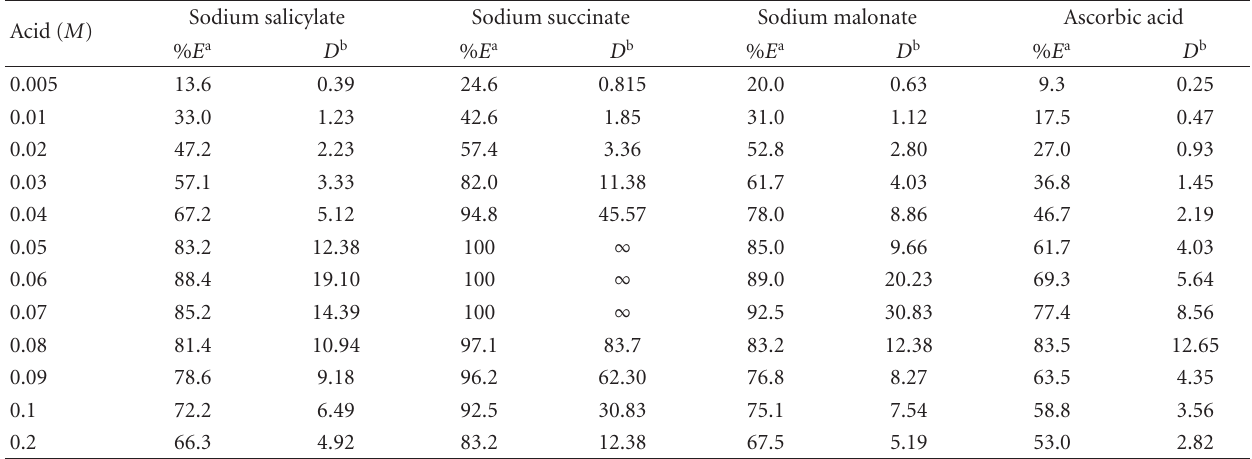
a Percentage extraction, b distribution ratio.